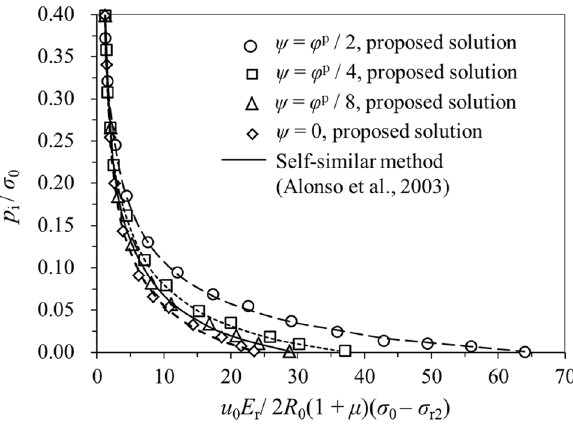
Figure 4. Variations of dimensionless support pressure p i / σ 0 versus dimensionless radial displacement u 0 E r / 2 R